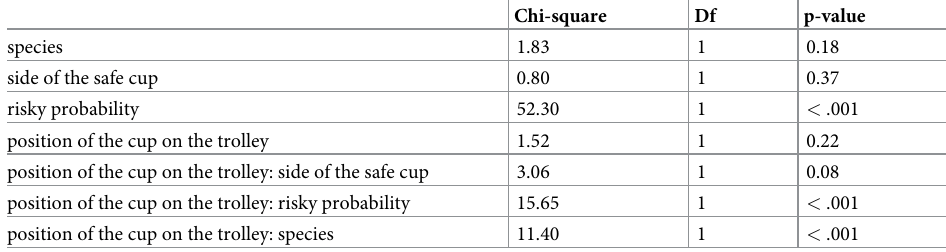
Table 5. Fixed effects of the final model investigating positional biases in Experiment 2. The table reports the results of the analysis of deviance (type II Wald chi-square tests) for Experiment 2.